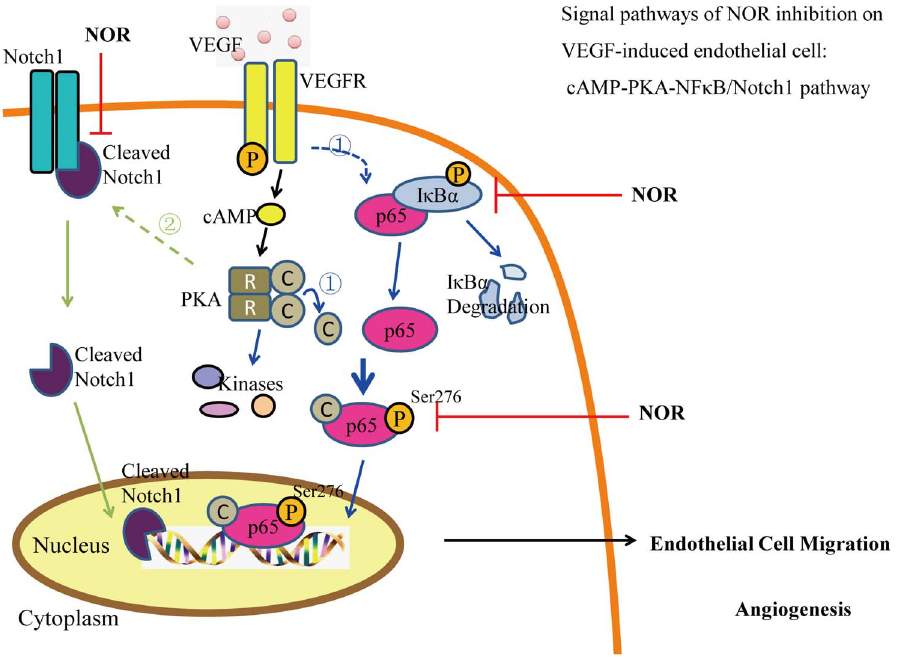
Figure 11. Signal pathways by which NOR inhibits the VEGF-induced endothelial cell migration: cAMP-PKA-NF- k B/Notch1 pathway. In details, NOR markedly suppressed VEGF-induced intracytoplasmic cAMP production and thereby PKA activation. This action, on one hand, inhibited I k B a degradation and p65/I k B a complex disruption, and then restrained PKAc/p65 complex formation and p65(ser276) phosphorylation to limit transcriptional activation potential of p65; on the other hand, promoted VEGF-induced the release of Notch1 active domain-Cleaved Notch1 to improve expressions of Notch1 targeted genes. NOR, norisoboldine.